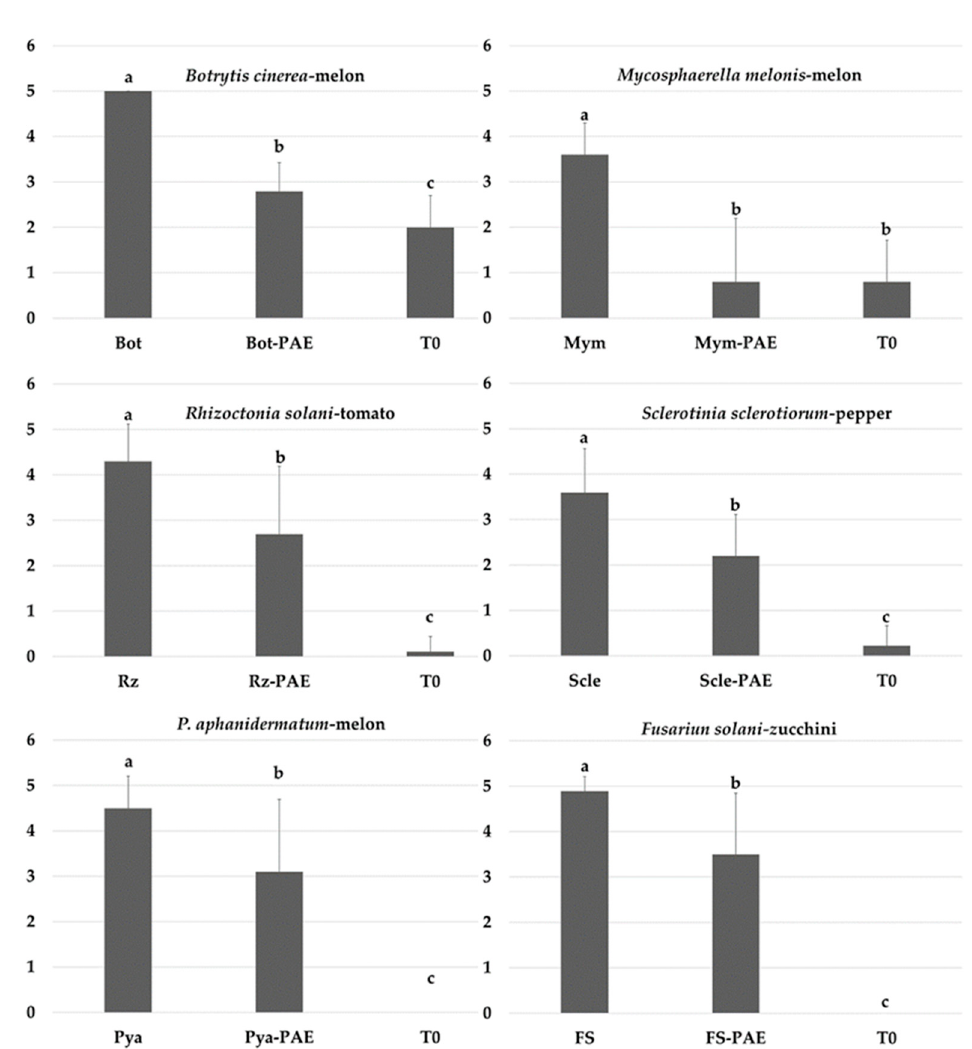
Figure 8. Disease severity of phytopathogens in plants was assessed 30–60 days after inoculation based on a scale from 0 to 5, where 0 indicates no visible disease symptoms and 5 indicates a dead plant. Bars indicate mean standard deviations (24 plants/repetition). Means with the same letter are not significantly different (least significant differences) according to an analysis of variance.